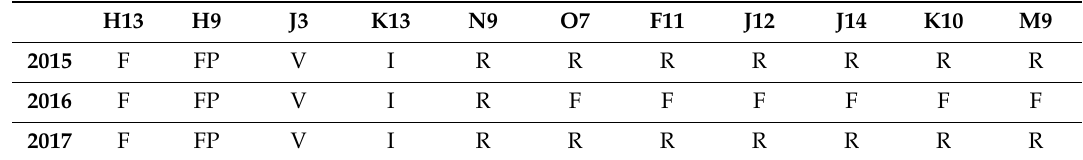
Table 2. Land use of the region where 11 in situ stations, of the REMEDHUS network, were located, Figure 2015. 2016, and 2017 (provided by the Water Resources Research group of the University of Salamanca). The land uses are: fallow (F), rainfed (R), forest-pasture (FP), vineyard (V), irrigated (I). H13